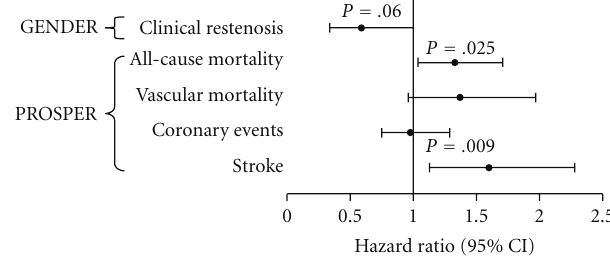
Figure 1: Marburg I hazard ratios for vascular endpoints in GENDER and PROSPER. The Marburg I (G534E) polymorphism is associated with an increased risk for stroke and mortality in the PROSPER study, whereas it tends to reduce the risk for clinical restenosis in the GENDER study.